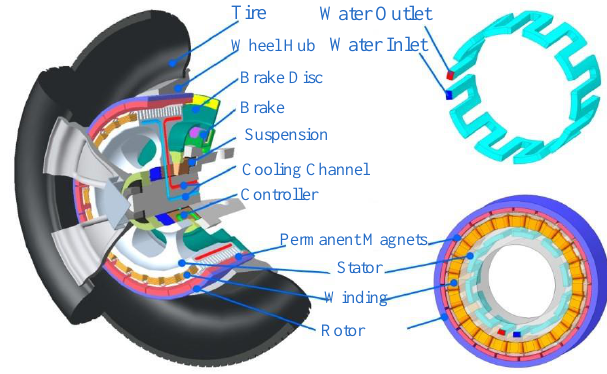
Figure 13. Structure of integrated IWM with cooling jacket